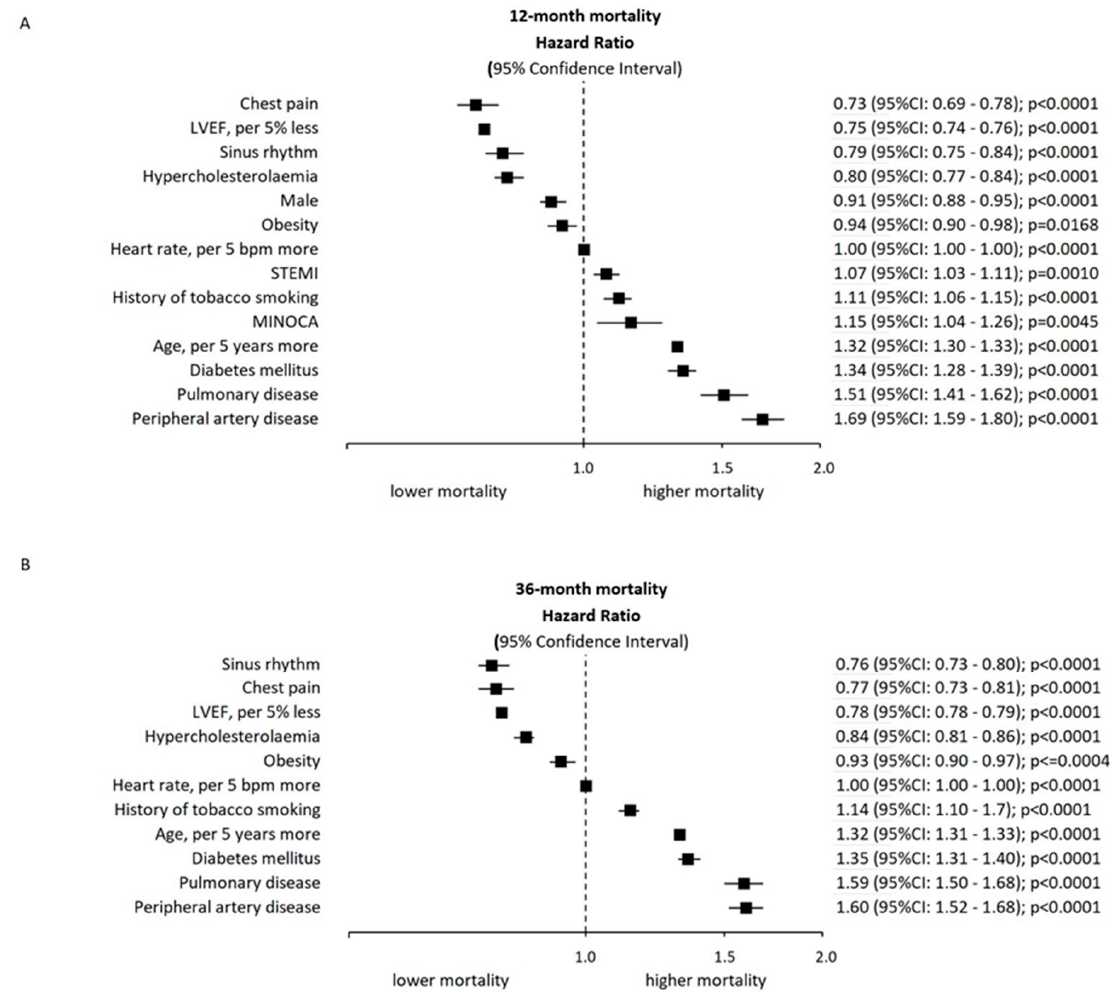
Figure 3. Multivariate analysis results. ( A ) 12 months results. ( B ) 36 months results.